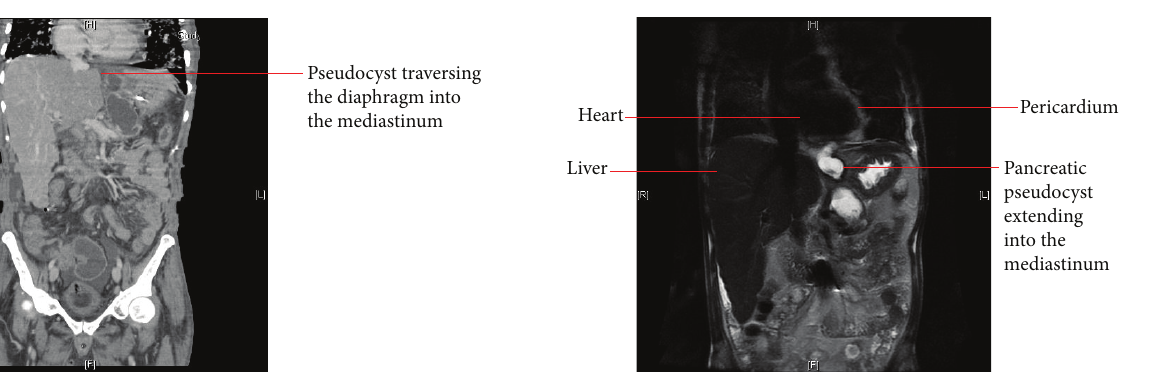
Figure 1: Abdominal CT showing cyst extension into mediastinum. Figure 2: MRCP showing cyst extension into the